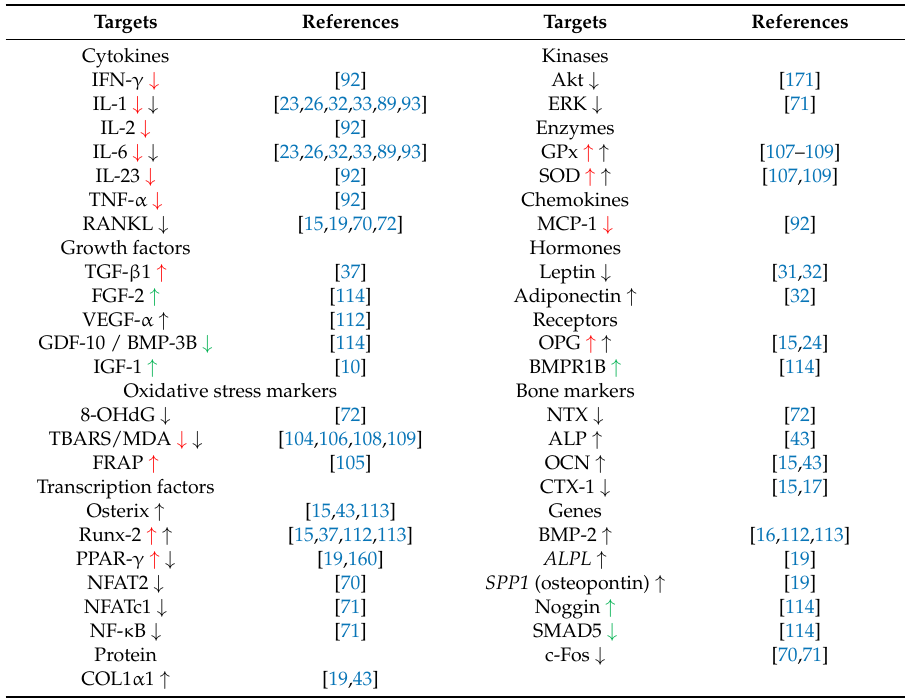
Table 1. The targets for vitamin E in the regulation of bone